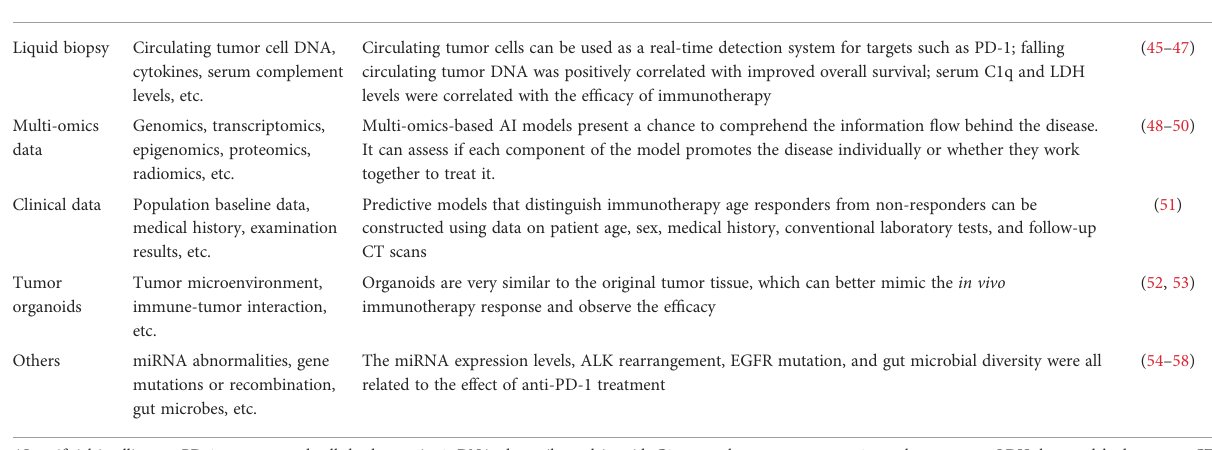
TABLE 1 Various strategies that have been shown to predict immunotherapy outcomes with